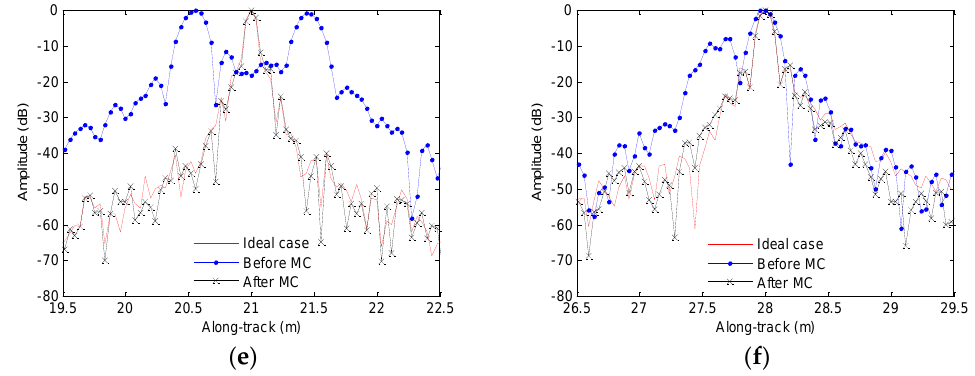
Figure 20. Results for sawtooth heave: ( a ) imaging result; ( b ) slice of T1; ( c ) slice of T2; ( d ) slice of T3; ( e ) slice of T4; ( f ) slice of T5. MC = motion compensation.